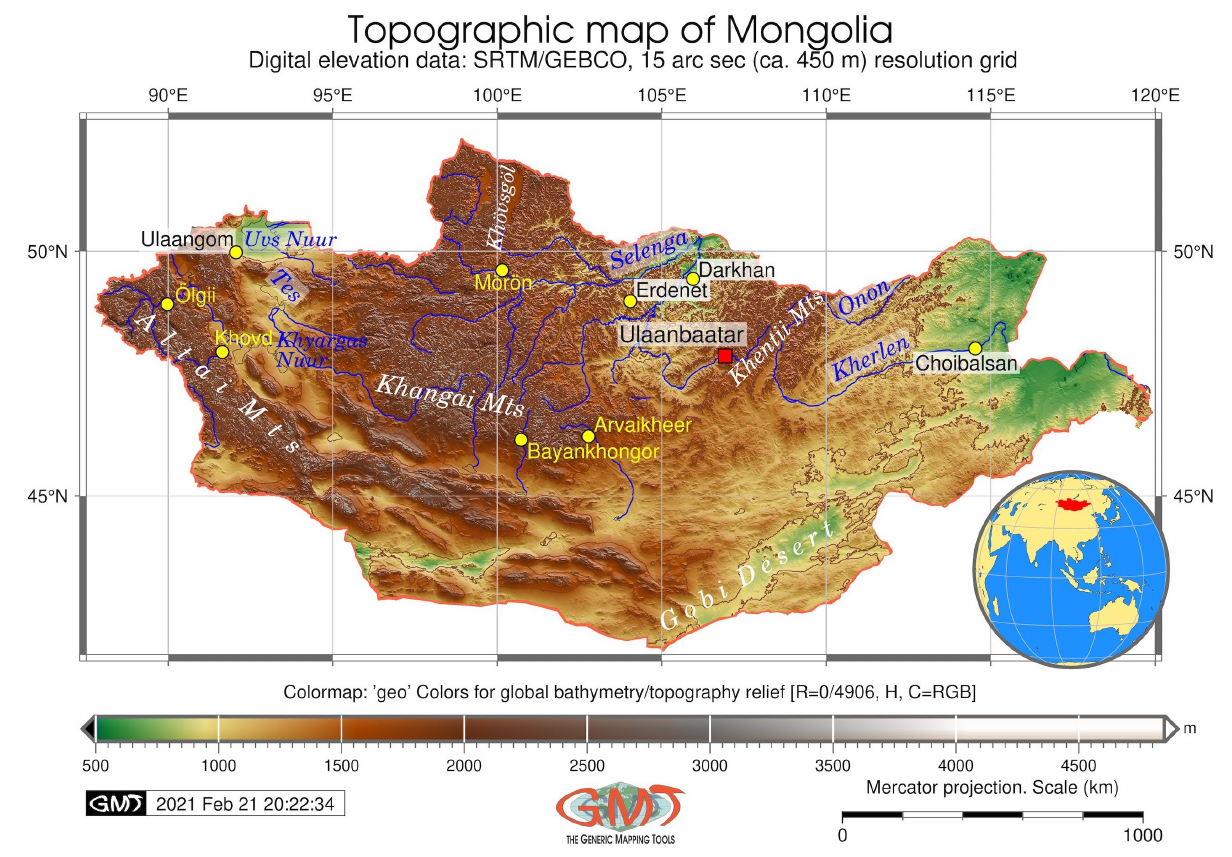
Fig. 1. Topographic map of Mongolia. Mapping: GMT. Source: